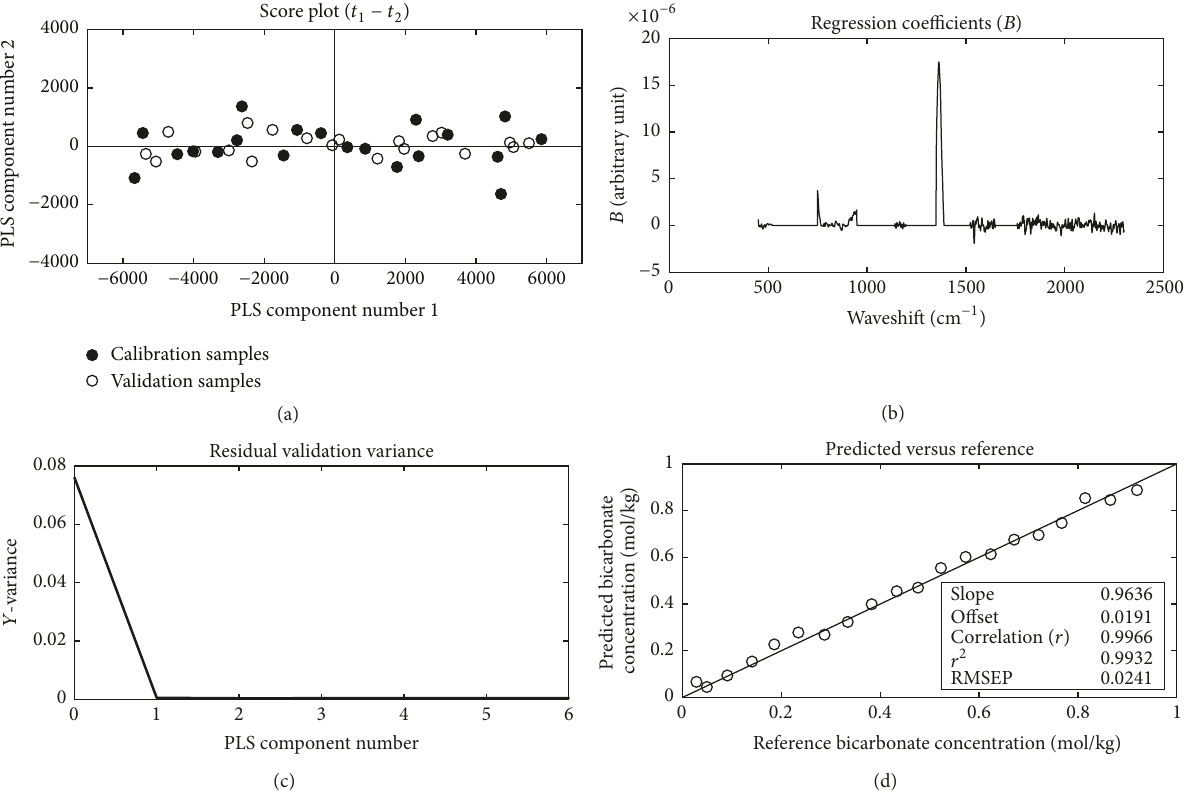
Figure 5: PLS-R model for bicarbonate. (a) Score plot of PLS components 1 versus 2 showing the calibration samples and validation samples. (b) Regression coefficients based on a one-component PLS-R model. (c) The residual validation variance shows that one PLS-component is optimal. (d) Predicted bicarbonate concentrations based on the one-component PLS-R model versus the reference concentrations obtained from the solution preparation